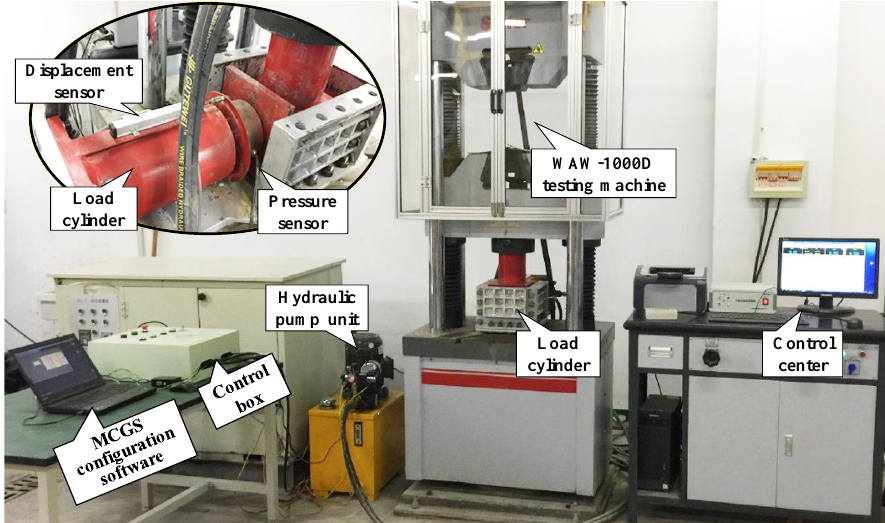
Figure 3. Bidirectional loading test system.